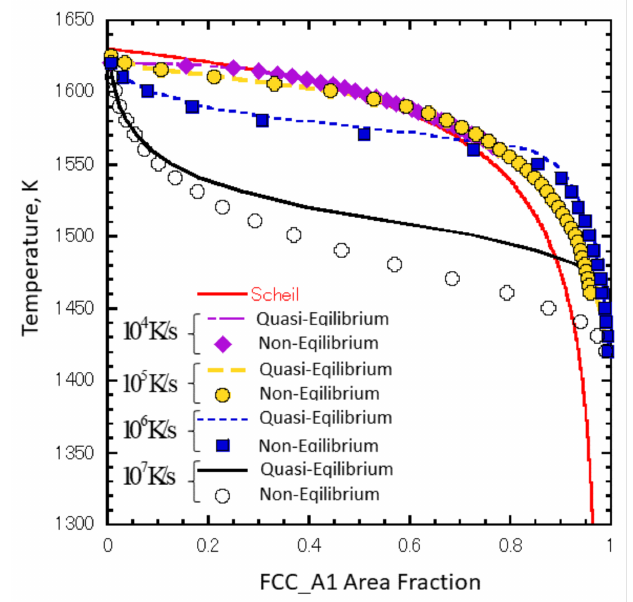
Figure 5. Temperature variations versus FCC area fraction at various cooling rates (10 4 K/s, 10 5 K/s, 10 6 K/s and 10 7 K/s) for non- and quasi-equilibrium MPFMs and the Scheil